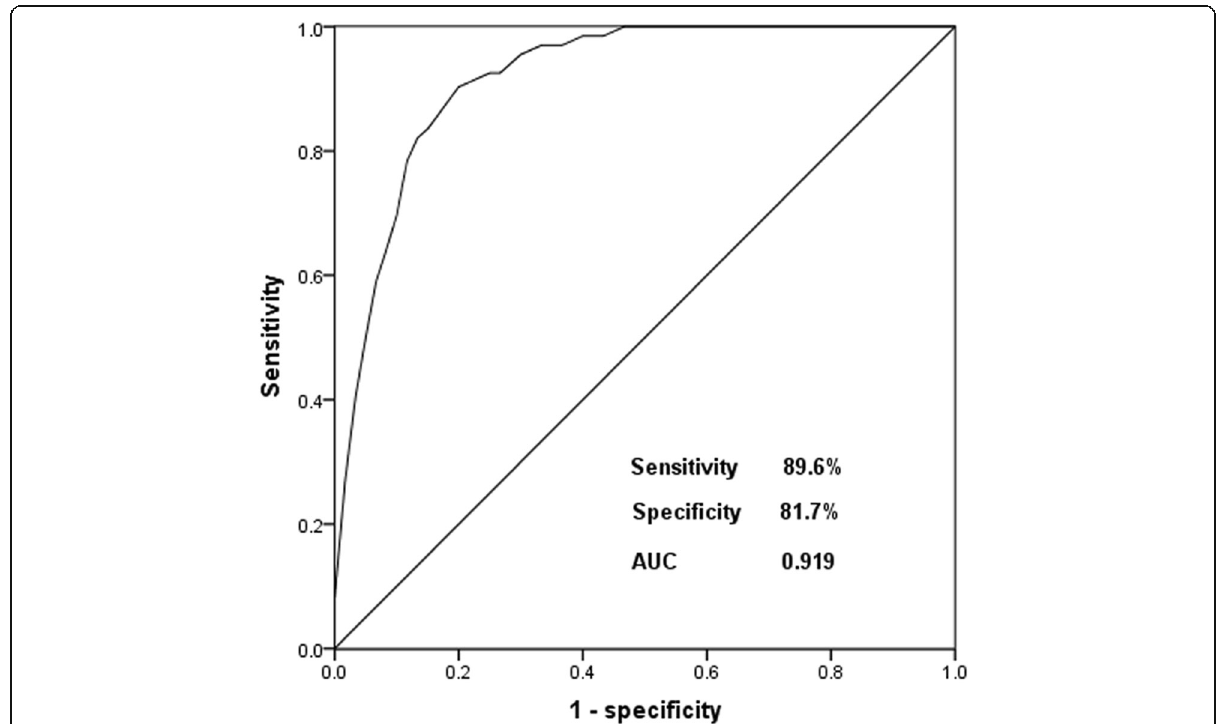
Fig. 2 ROC curve was constructed to evaluate the diagnostic value of miR-186-5p for asymptomatic CAS. In the ROC curve analysis, the AUC was 0.919, with the sensitivity of 89.6% and specificity of 81.7% at the cutoff value of